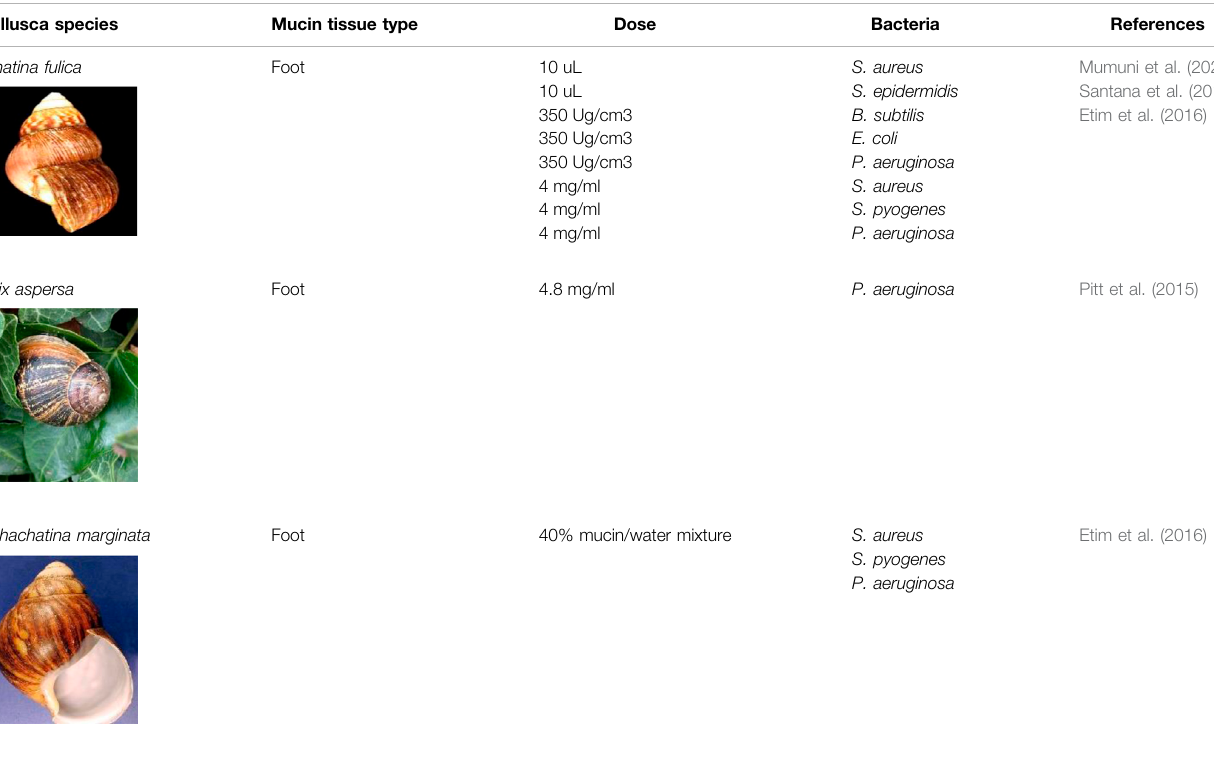
TABLE 2 | Molluscan mucin applied as antimicrobials to inhibit